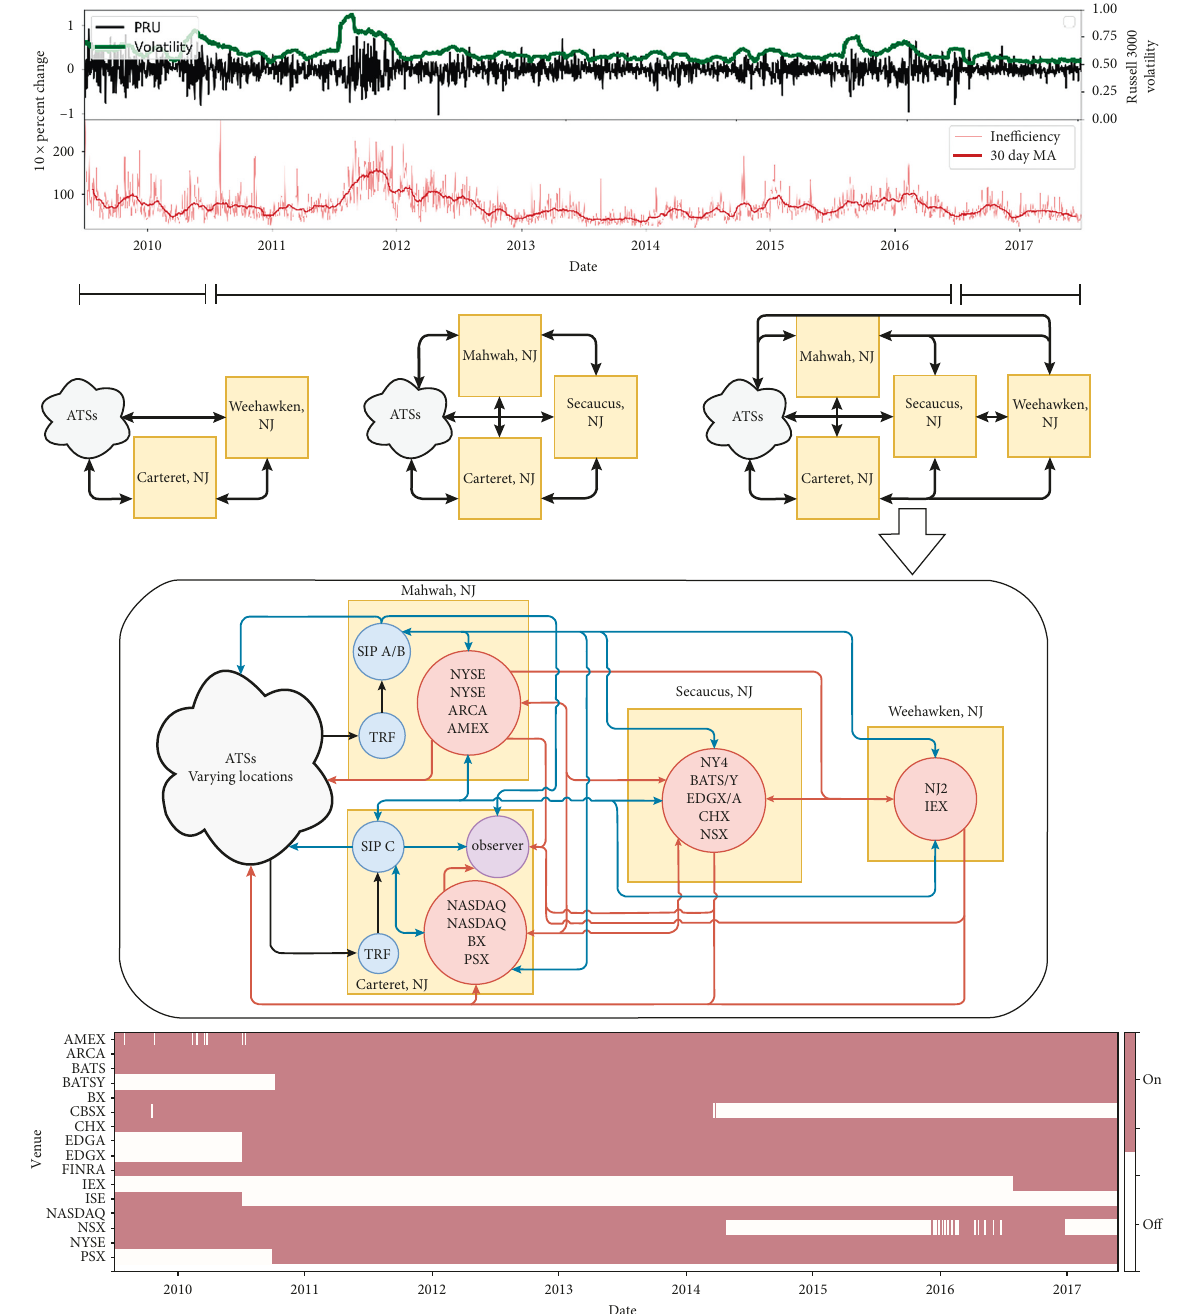
Figure 1: The U.S. national market system (NMS) is a complex, multilayered system exhibiting dynamic behaviors that vary based on network topology, active trading strategies, the regulatory environment, and more. The top panel shows several time series generated by the system, namely, the returns and volatility for the trading symbol PRU, along with an indicator for information asymmetry intensity. The second panel investigates higher-level system dynamics, displaying some of the network topologies that the NMS has assumed over the course of our study period (Q3 2009 – Q2 2017). The third panel shows a more detailed view of the NMS as it stood in September 2016, following IEX’s transition from an alternative trading system to a national securities exchange. The final panel summarizes the activity profiles for all exchanges that functioned during our study period. Shaded dates indicate that an exchange was active, while unshaded dates indicate abnormal or unexpected inactivity. Expected outages, such as weekends and holidays, are not